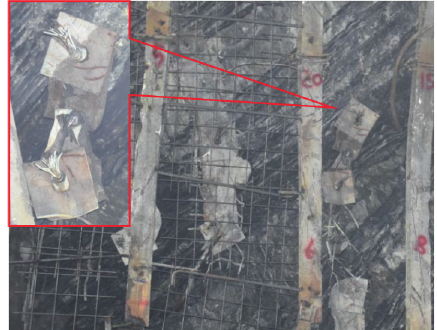
Figure 15: Release of prestressed anchor cable.